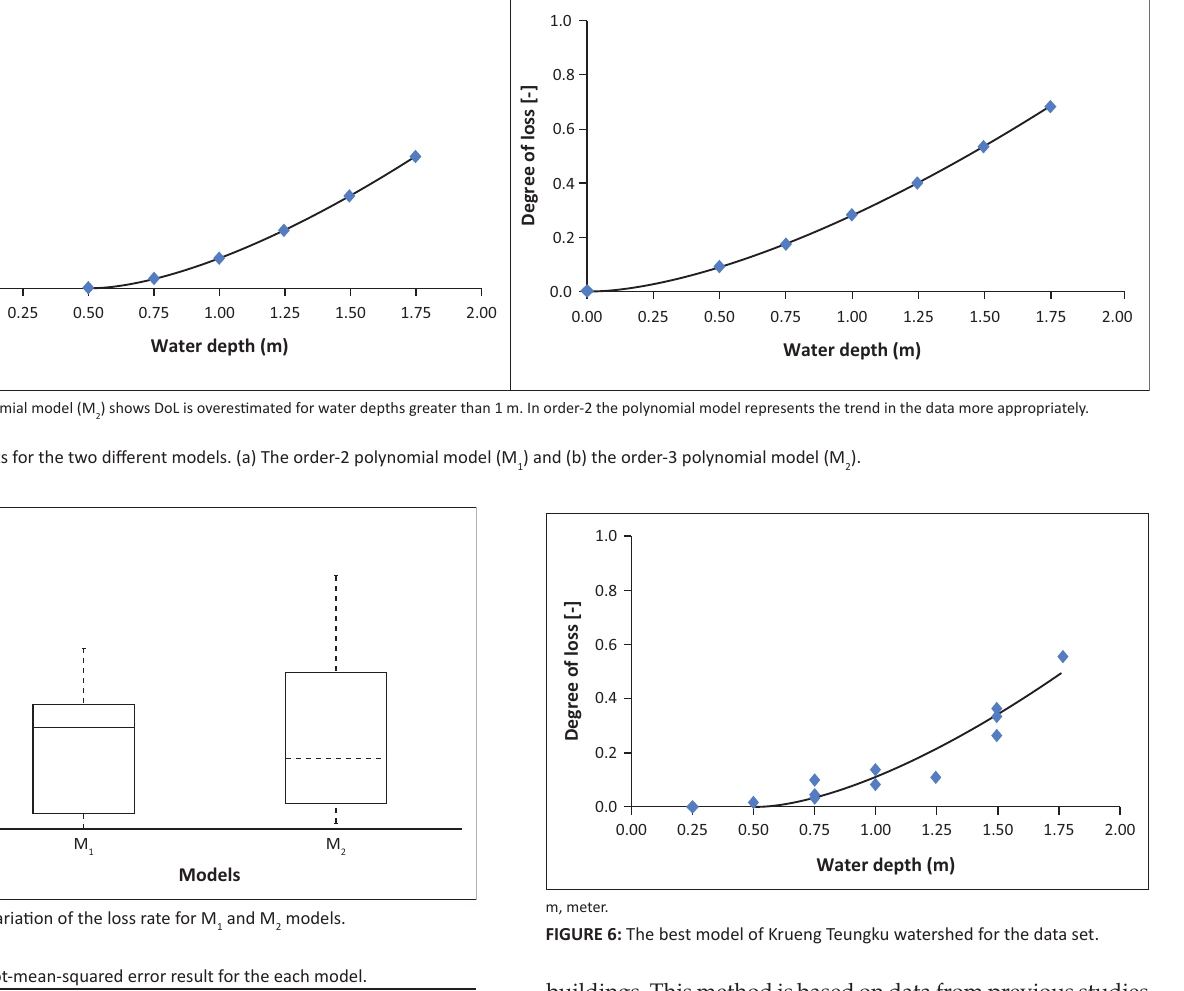
FIGURE 6: The best model of Krueng Teungku watershed for the data